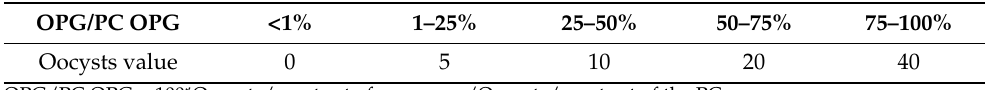
Table 1. Conversion between oocysts percent gram and oocysts value. OPG/PC OPG